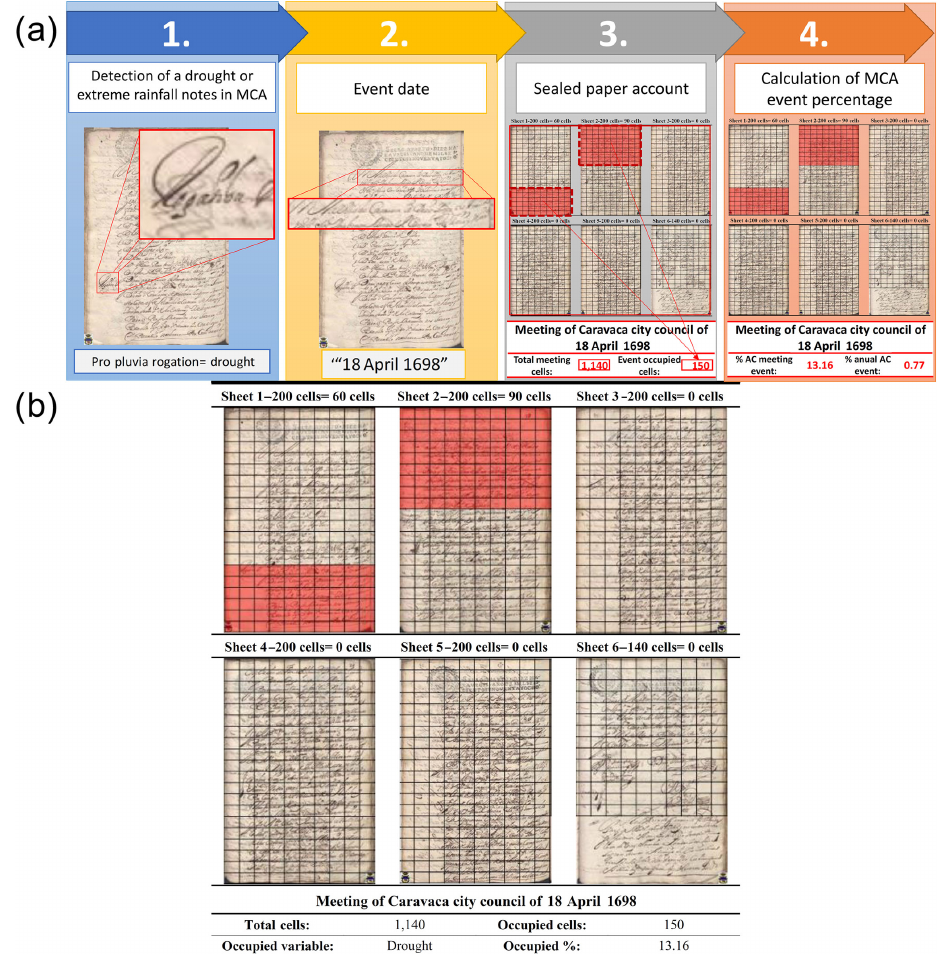
Figure 5. COST method by step (a) and an example the COST method encoding (b) . The coded source is the same as in Figs. 3 and 4 to emphasise how the three different approaches are applied in practice. This particular example refers to a PPR on 18 April 1698, so the reconstructed variable is drought. Source: the Carmesi